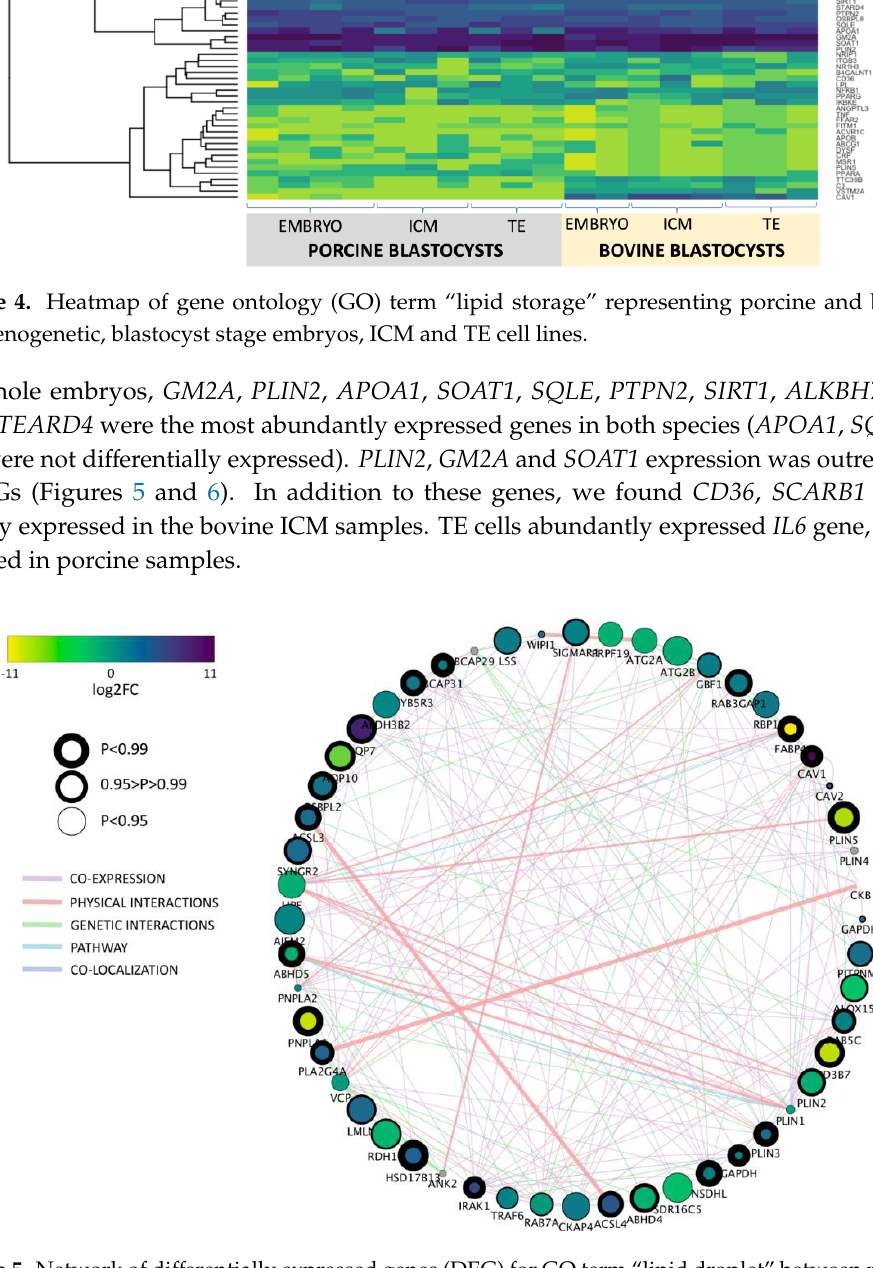
Figure 5. Network of differentially expressed genes (DEG) for GO term “lipid droplet” between porcine and bovine parthenogenetic, blastocyst stage embryos. Negative log2FC values indicate an upregulation of genes in porcine embryos. Node envelope thickness expressed as NOIseq probability value.